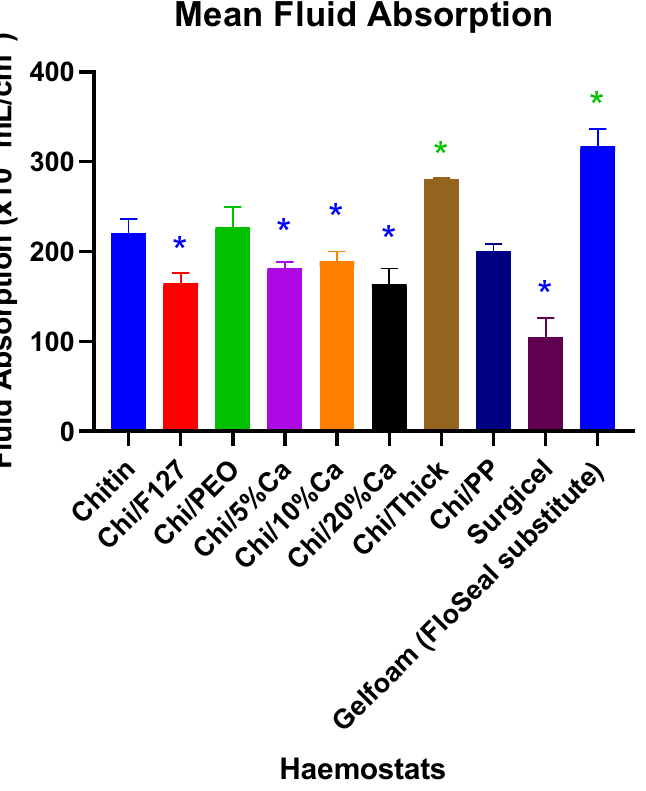
Figure 8. Fluid absorbed by modified and non-modified beta-chitin patches, Surgicel and FloSeal, per unit area (× 10 −3 mL/cm 2 ). *p < 0.05, significantly lower compared to non-modified beta-chitin patch. *p < 0.05, significantly higher compared to non-modified beta-chitin patch analysed by Kruskal–Wallis one-way ANOVA with Dunn’s test, n =